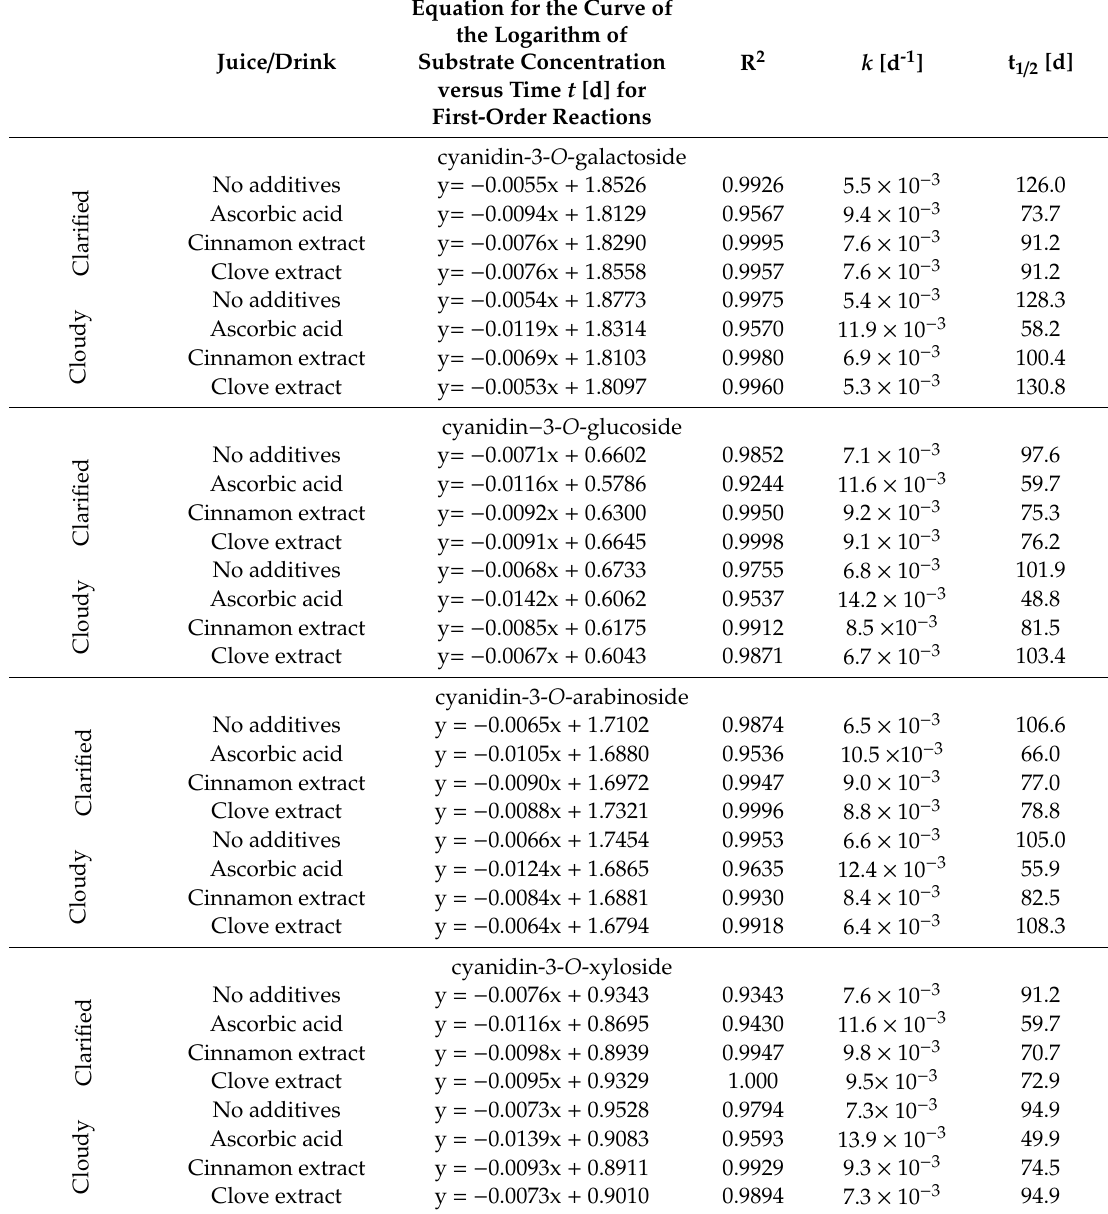
Table 7. Equation of the curve for degradation, constant reaction rate and half-life of anthocyanins in chokeberry